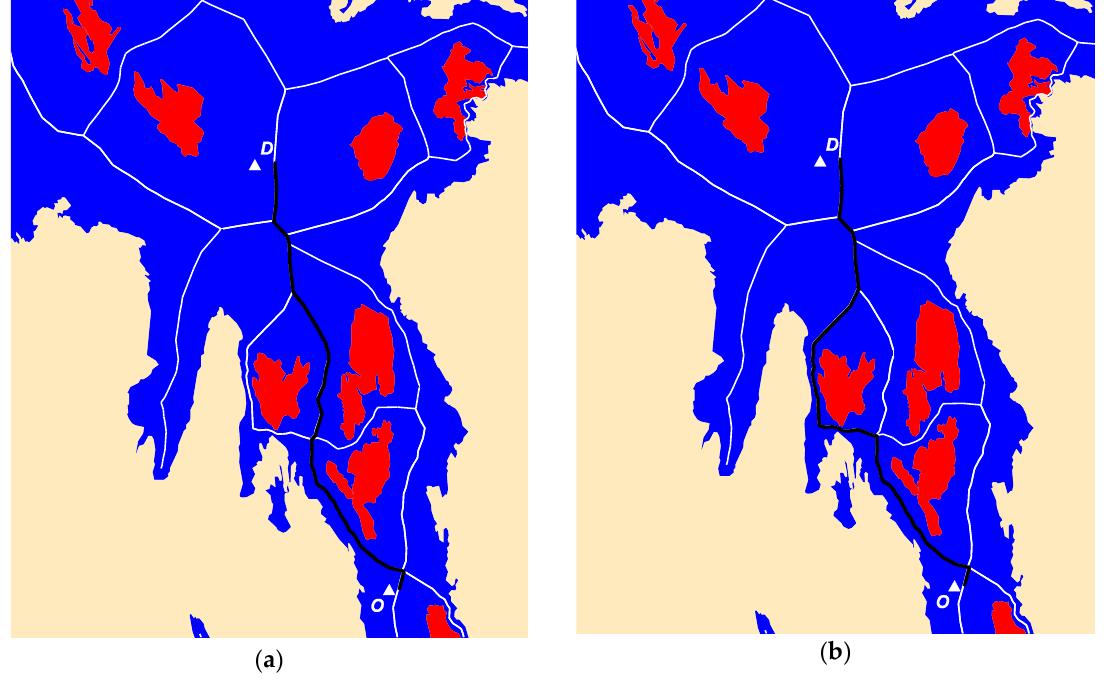
Figure 9. The shortest and safest path ( a ) in black and the weighted shortest and safest path ( b ) in black between Origin and Destination pair for ship type CAC3.